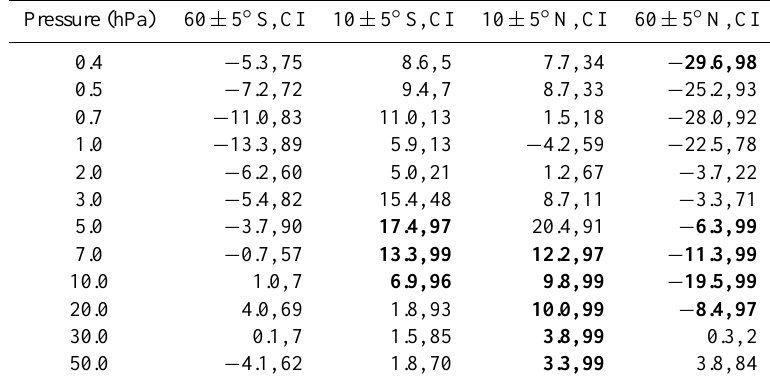
Table 3. Southern Hemisphere and Northern Hemisphere tropical and extratropical CH 4 trend profiles (% decade − 1 ) and their associated confidence intervals (CI in %) for the presence of the terms in the MLR models. Significant trends are in bold. Pressure (hPa) 60 ± 5 ◦ S, CI 10 ± 5 ◦ S, CI